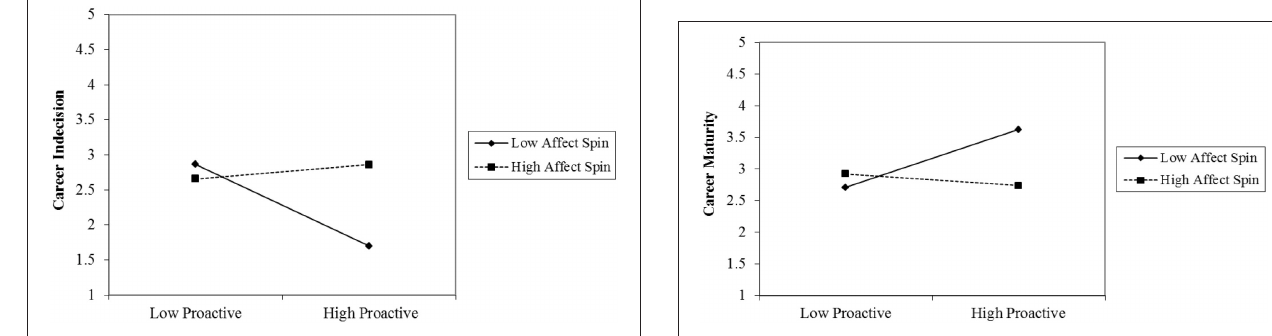
FIGURE 4 | The moderating effect of affect spin in the relationship between proactive personality and career indecision.